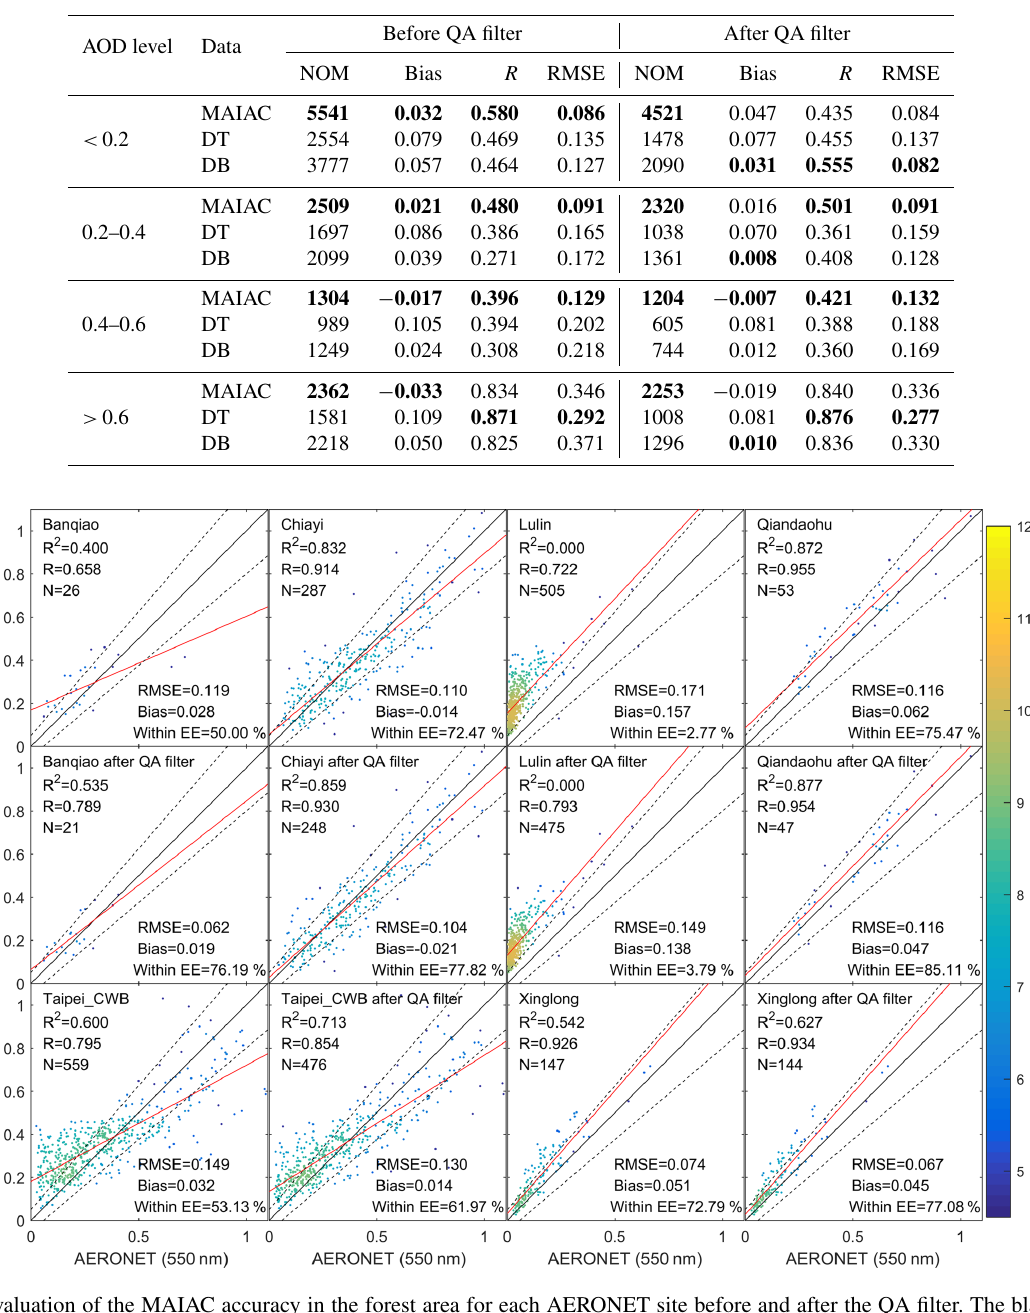
Table 3. Accuracy evaluation of MAIAC, DT, and DB at the low level ( < 0.2), moderate level (0.2–0.4), moderate-high level (0.4–0.6), and high level ( > 0.6). NOM is the abbreviation for number of matches. The bold number is the highest peformance among three algorithms by each indicator.